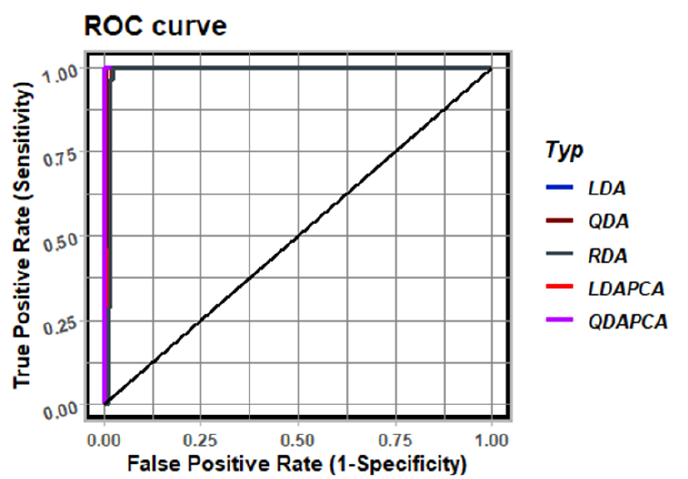
Figure 11. ROC analysis for results shown in Figure 9.